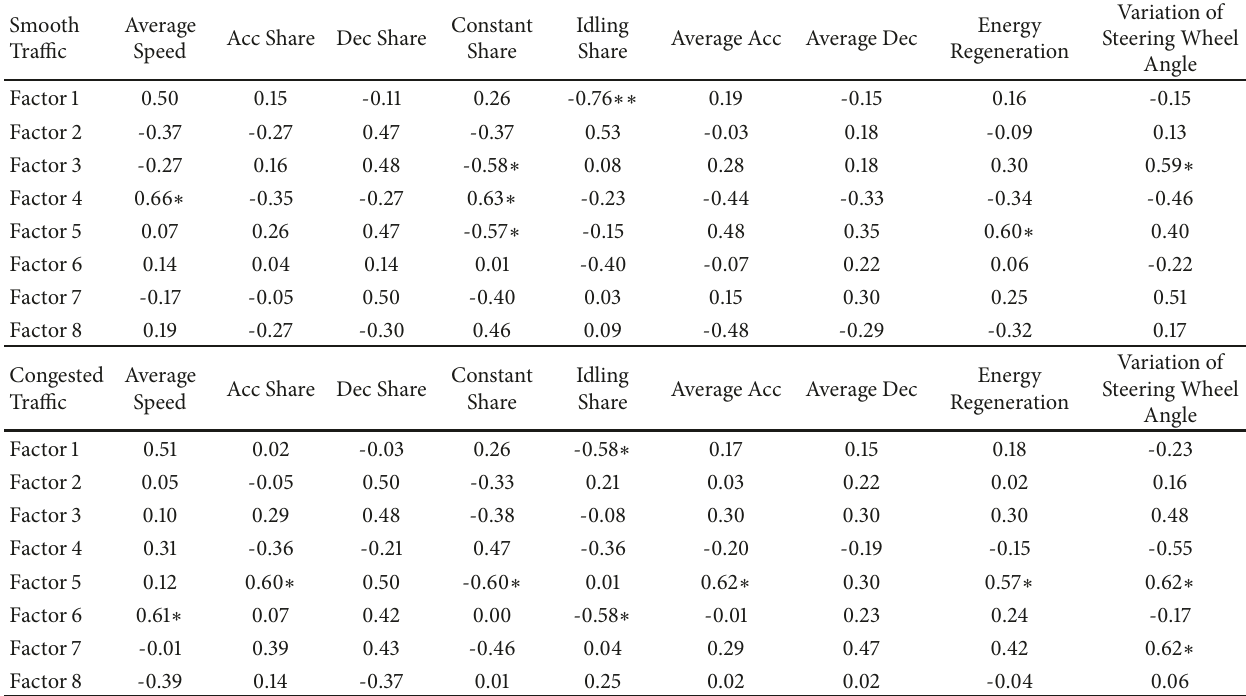
Table 4: Correlations between DSQ and measured driving behaviors.